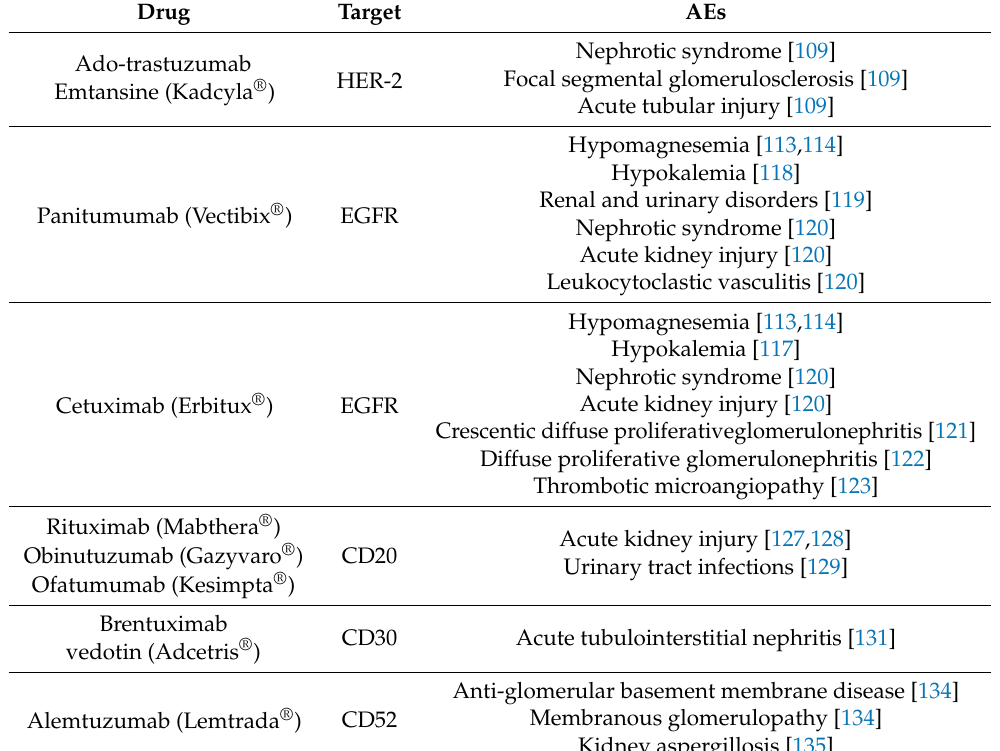
Table 4. TT-mAb-induced nephrotoxicity. Drug Target AEs